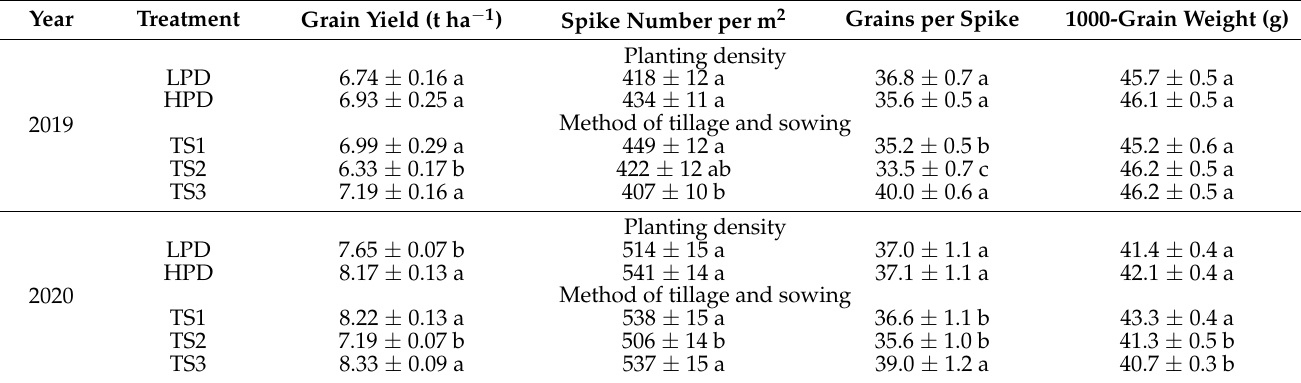
Table 2. Effects of planting density and method of tillage and sowing on grain yield and yield components in 2019 and